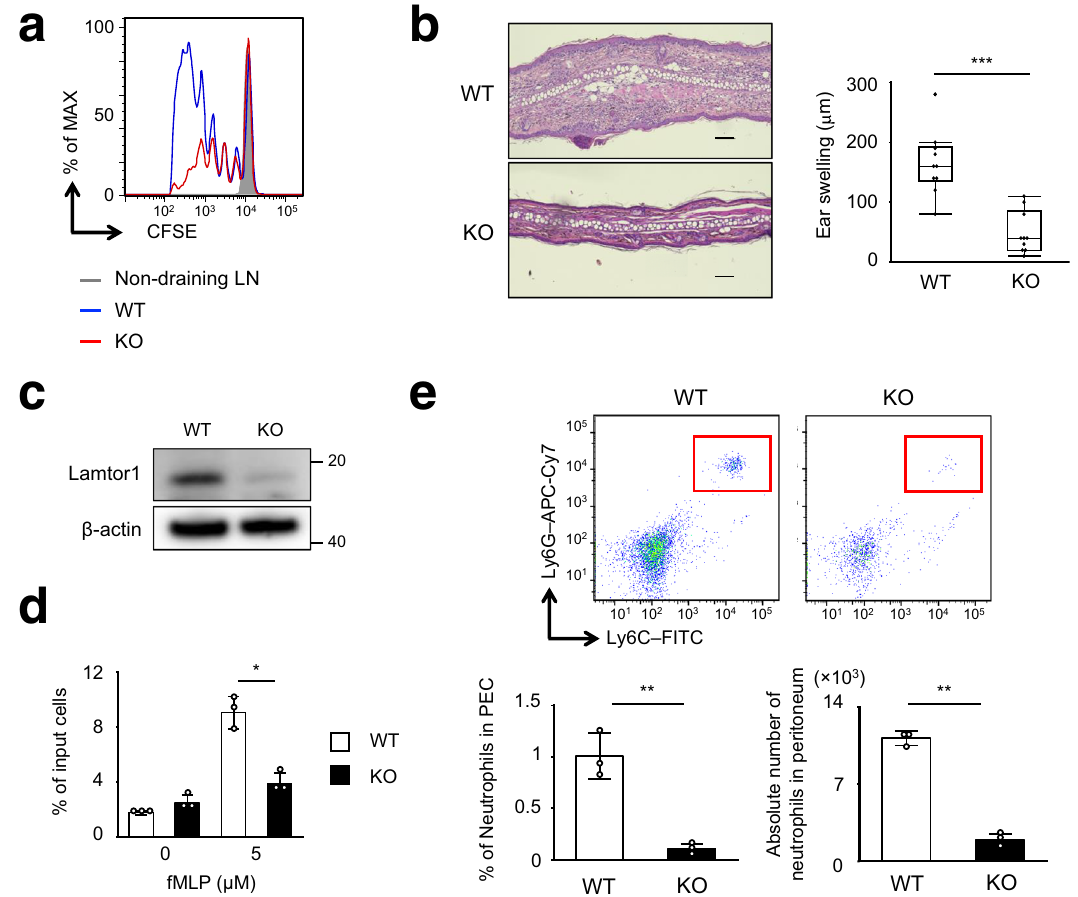
Fig. 9 Impaired in vivo T cell priming and neutrophil traf fi cking under Lamtor1 de fi ciency. a In vivo OT-II T-cell proliferation following subcutaneous injection of OVA protein. After intravenous transfer of CFSE-labeled CD4 + OT-II T cells into WT (blue line) or CD11c – Lamtor1 fl ox/ fl ox (red line) recipient mice, OVA protein in complete Freund ’ s adjuvant was subcutaneously injected into the footpads of recipient mice. CFSE-dilution of OT-II T cells in popliteal LNs was analyzed by FACS. Data are representative of three independent experiments. b Hapten-induced contact hypersensitivity (CHS) in WT and CD11c – Lamtor1 fl ox/ fl ox mice. Five days after sensitization with DNFB in acetone, DNFB was applied to the ears. Forty-eight hours after the DNFB challenge, histological analysis (left) and evaluation of ear thickness (right) were performed ( n = 10). Representative images are shown of WT (top) and CD11c – Lamtor1 fl ox/ fl ox (bottom) mice. Scale bar, 100 μ m. c Lamtor1 expression in neutrophil of WT and LysM- Lamtor1 fl ox/ fl ox mice. Neutrophils isolated from BM from WT and LysM- Lamtor1 fl ox/ fl ox mice (KO) were lysed, and Lamtor1 expression was evaluated by western blotting. Data are representative of three experiments. d Chemotaxis of neutrophils in response to fMLP. Chemotaxis of WT (white bar) and Lamtor1 – / – neutrophils (black bar) in response to fMLP (5 μ M) was determined by Transwell assay (pore size, 3 μ m). Data are representative of three experiments. e LPS-induced in vivo neutrophil mobilization. LPS was administered into the peritoneum of WT (WT, white bar) and LysM- Lamtor1 fl ox/ fl ox mice (KO, black bar). Six hours after administration, cells in the peritoneal cavity were isolated and stained for CD11b, Ly6C, and Ly6G, and the number of CD11b + Ly6G + neutrophils (red rectangle) was counted by FACS (upper). Population (left) and absolute number (right) of CD11b + Ly6G + neutrophils are shown (lower) ( n = 3). Statistical analysis was performed by two-sided Student ’ s t -test ( d , e ) [means ± s.d.; * p < 0.05, ** p < 0.01] or two-sided Mann – Whitney U -test ( b ) [median, 25th and 75th percentiles, and minimum and a maximum of a population excluding outliers; *** p <